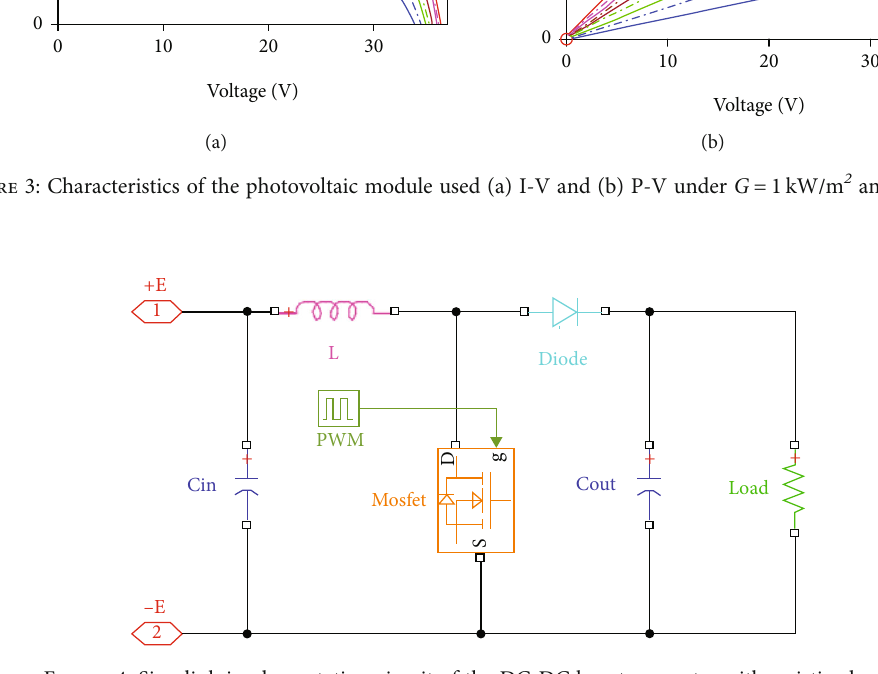
Figure 4: Simulink implementation circuit of the DC-DC boost converter with resistive load.